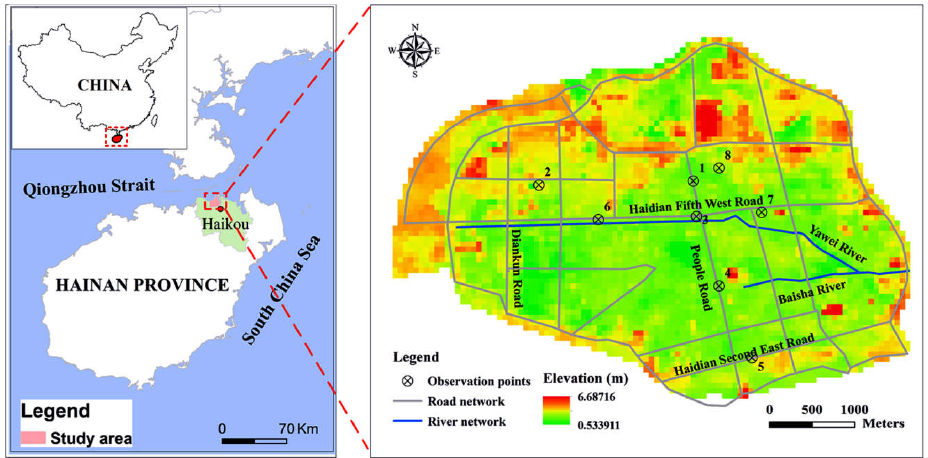
Figure 1. Location of the study area.